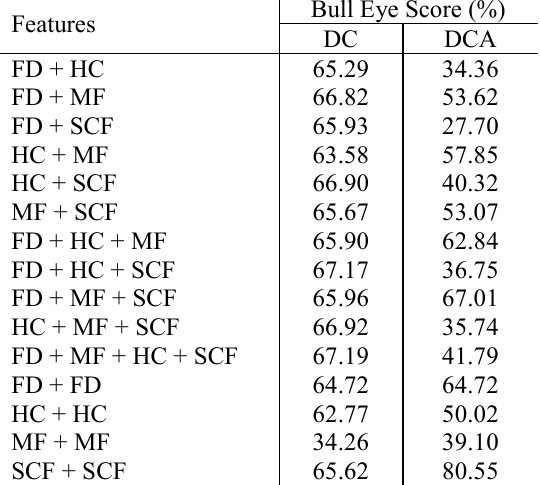
Table 2. Bull Eye Score on MPEG-7 dataset for both fusion Strategies: DC (Direct Concatenation) and DCA (Discriminant Correlation Analysis) is presented for different combination of features.